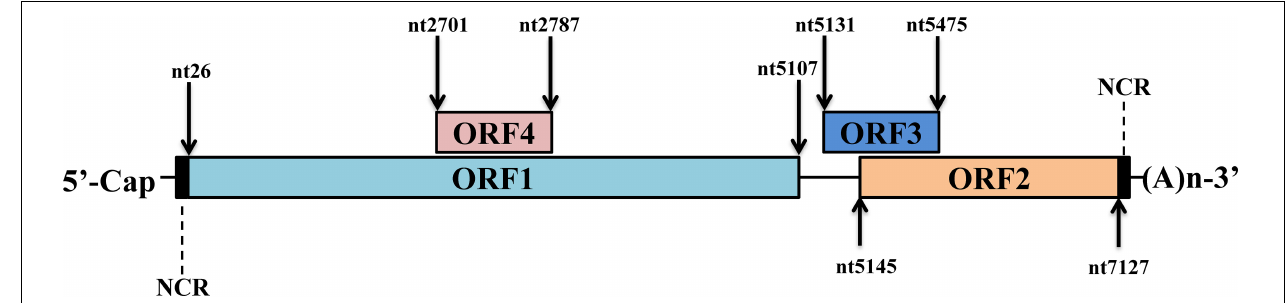
FIGURE 1 | Schematic illustration of HEV genome organization. Schematic illustration of HEV genome and location of ORFs. The ORF1 (nt 26–5107) is labeled above the genomic RNA box. ORF2 (nt 5145–7127) and ORF3 (nt 5131–5475) are encoded by the same subgenomic RNA. The numbers above or below the RNA boxes indicate nucleotide numbers of the cDNA of HEV-1 Sar55 strain (GenBank accession number: AF444002).